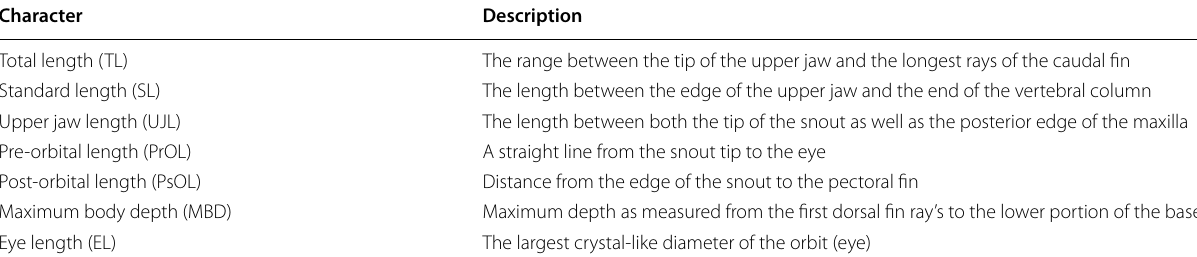
Table 2 Description of conventional morphometric features of H. limbatus